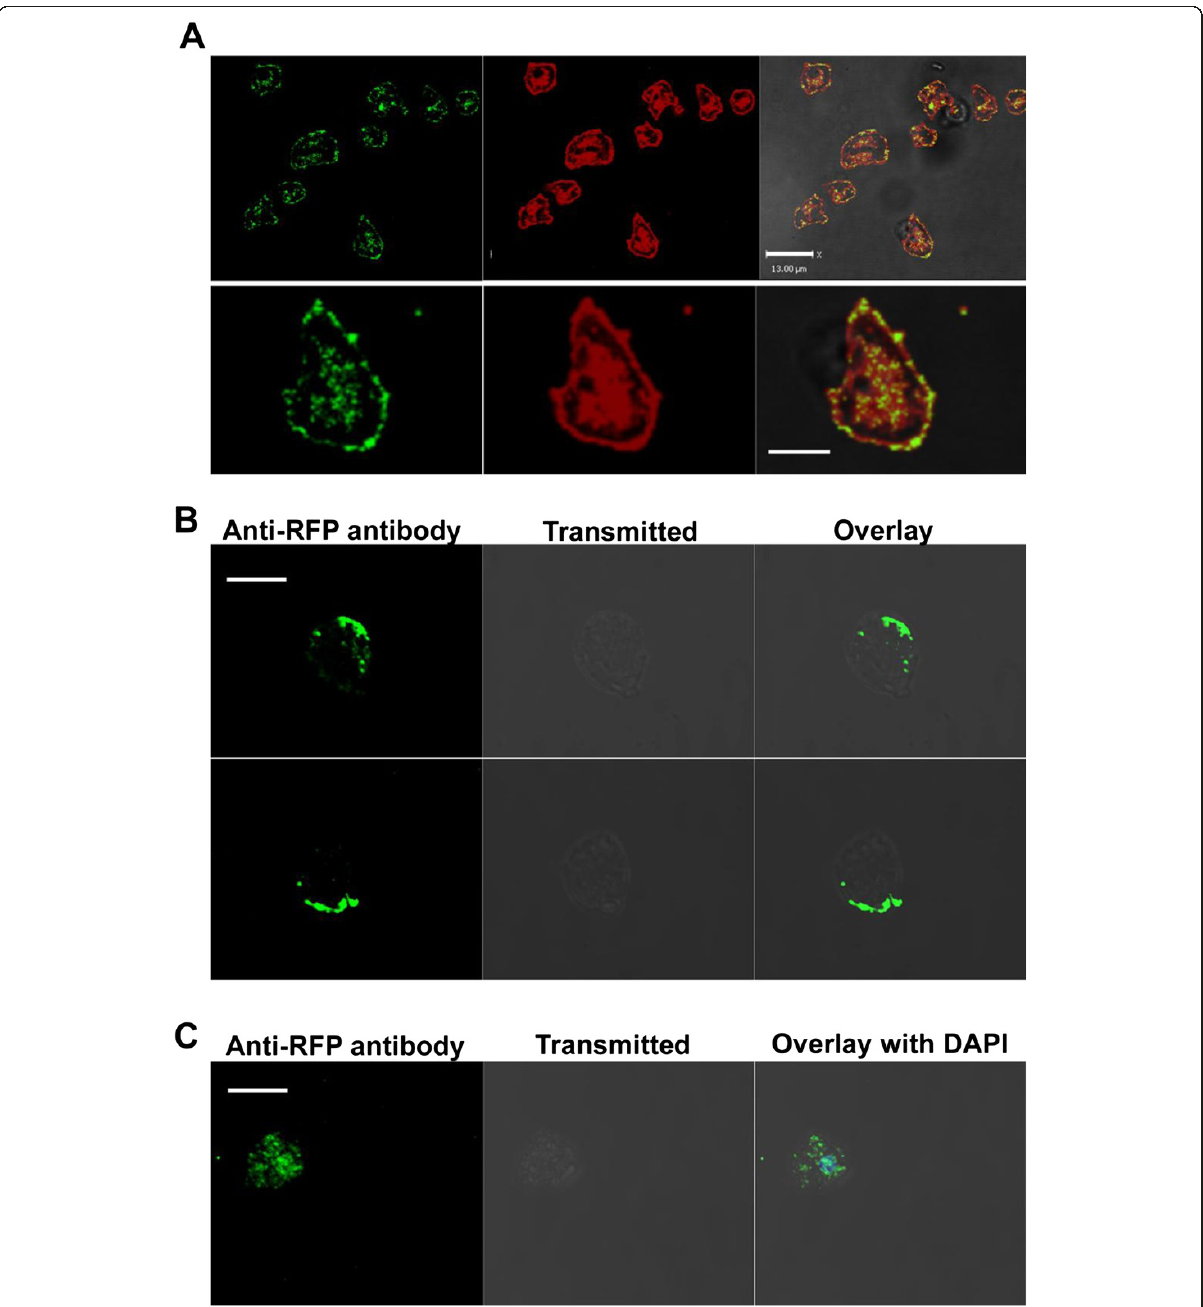
Figure 8 Some AmpA protein is found extracellularly on the cell surface. A ) Live cells were incubated with the membrane stain DiI and with rat anti-RFP antibody in the dark at room temperature. Cells were washed and then incubated for 1 hour with goat anti-rat antibody conjugated to Alexa-Fluor 488, then washed and fixed but never permeabilized. Images represent single optical sections of a z-series. Arrows indicate colocalization of mRFP-AmpA with DiI at the cell periphery. Scale bar is 13 um in the field images (top row) and 5 um in the zoom of a single cell (bottom row). B and C ) AmpA on the cell surface is endocytosed and traffics to a perinuclear endosomal recycling compartment. Live cells were incubated 4°C with rat anti-RFP antibody. B ) Some of the coverslips were maintained at 4°C to prevent endocytosis, washed to remove excess anti-mRFP antibody, fixed and then permeabilized and labeled with goat anti-rabbit second antibody. Slices of cells from a Z series to show that the labeling is largely on the outside of the cell and not in the interior. Scale bar is 10 um C ) Cells on the other coverslips (panels labeled 22 degrees) were washed to remove excess anti-mRFP antibody, then incubated at room temperature for 15 min to allow endocytosis of the antibody bound mRFP-AmpA and then fixed and permeabilized to allow labeling with second antibody to detect anti-RFP antibody that had been internalized with the AmpA. The image is a slice from a Z series. The scale bar is 10